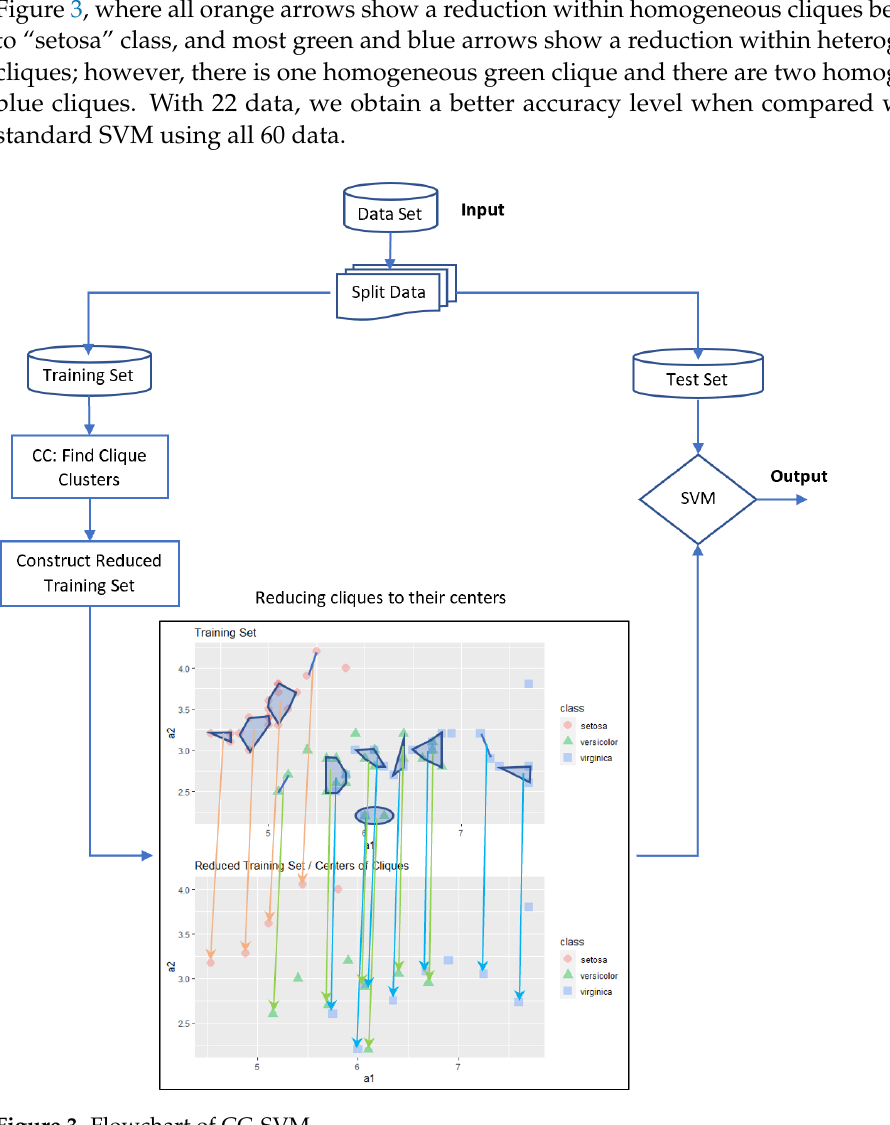
Figure 3. Flowchart of